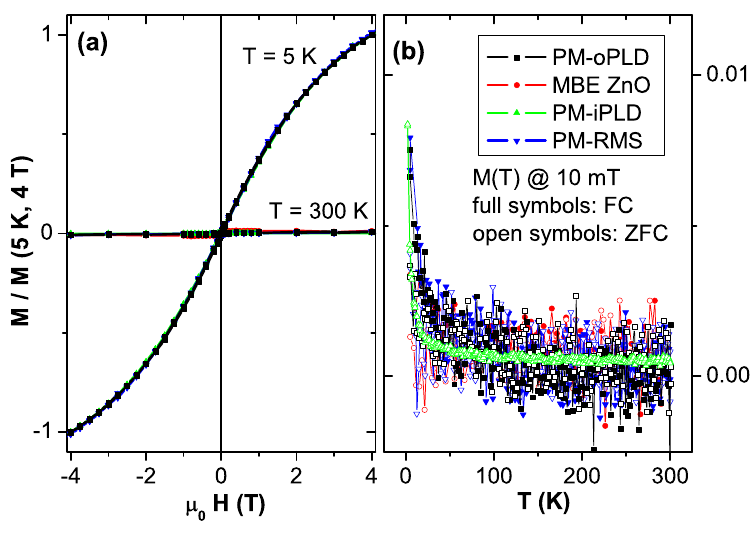
Figure 6. SQUID measurements on three Co:ZnO samples and the MBE ZnO reference. (a) displays M ( H ) -curves at 300 K and 5 K and (b) the respective M ( T ) in FC and ZFC conditions. All data are normalized to M (5 K, 4 T ) and the diamagnetic background of the substrate has been derived from the high-field behavior of the 300 K data and subtracted from all data